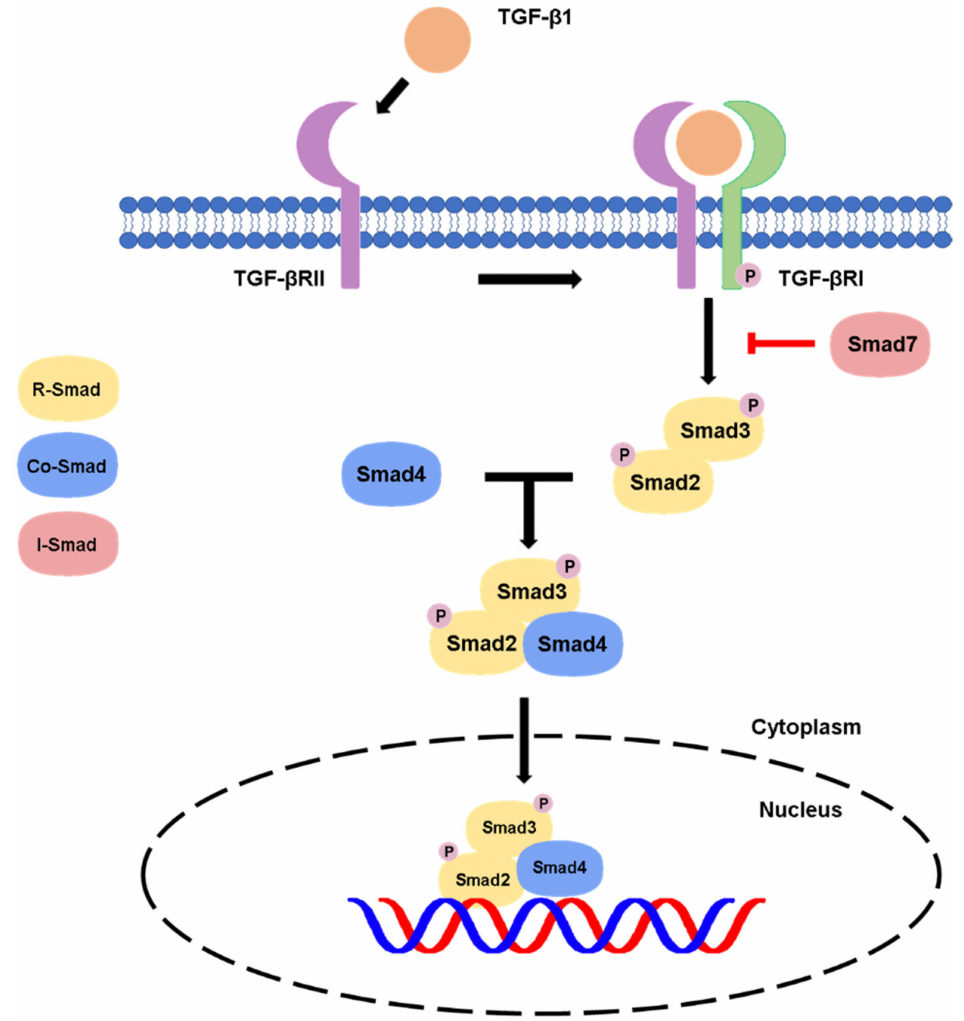
Figure 1. Canonical pathway of TGF- β